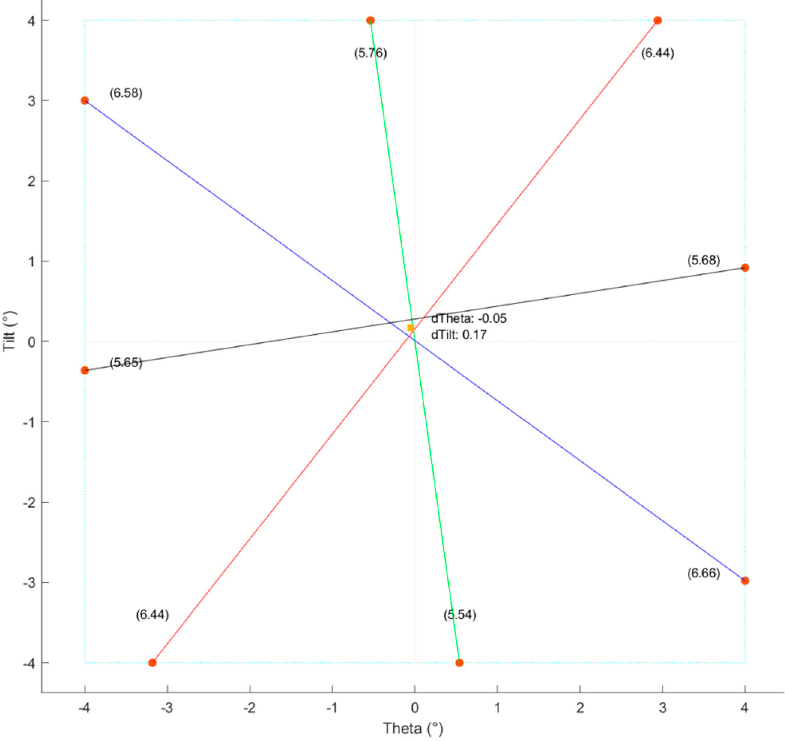
Figure 16. Visualization of measured planes and the main axes of crystal.